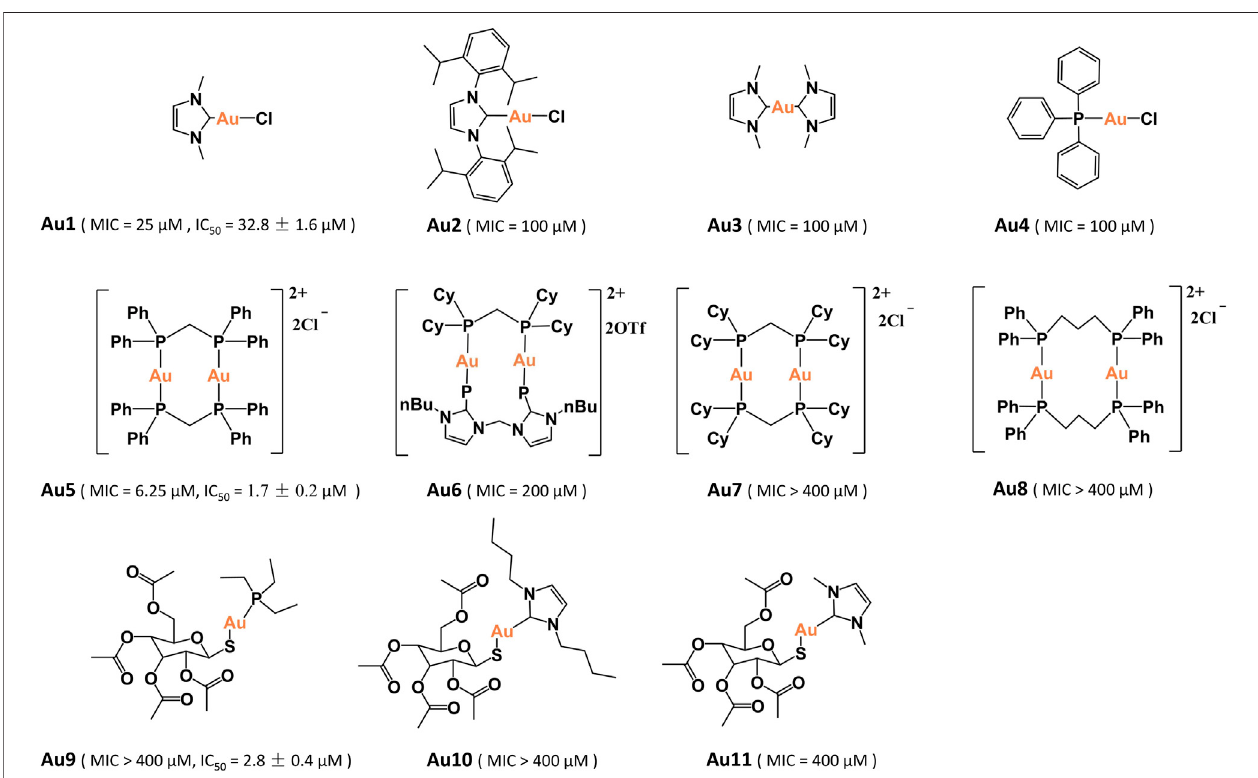
FIGURE 1 | Chemical structure of the gold(I)